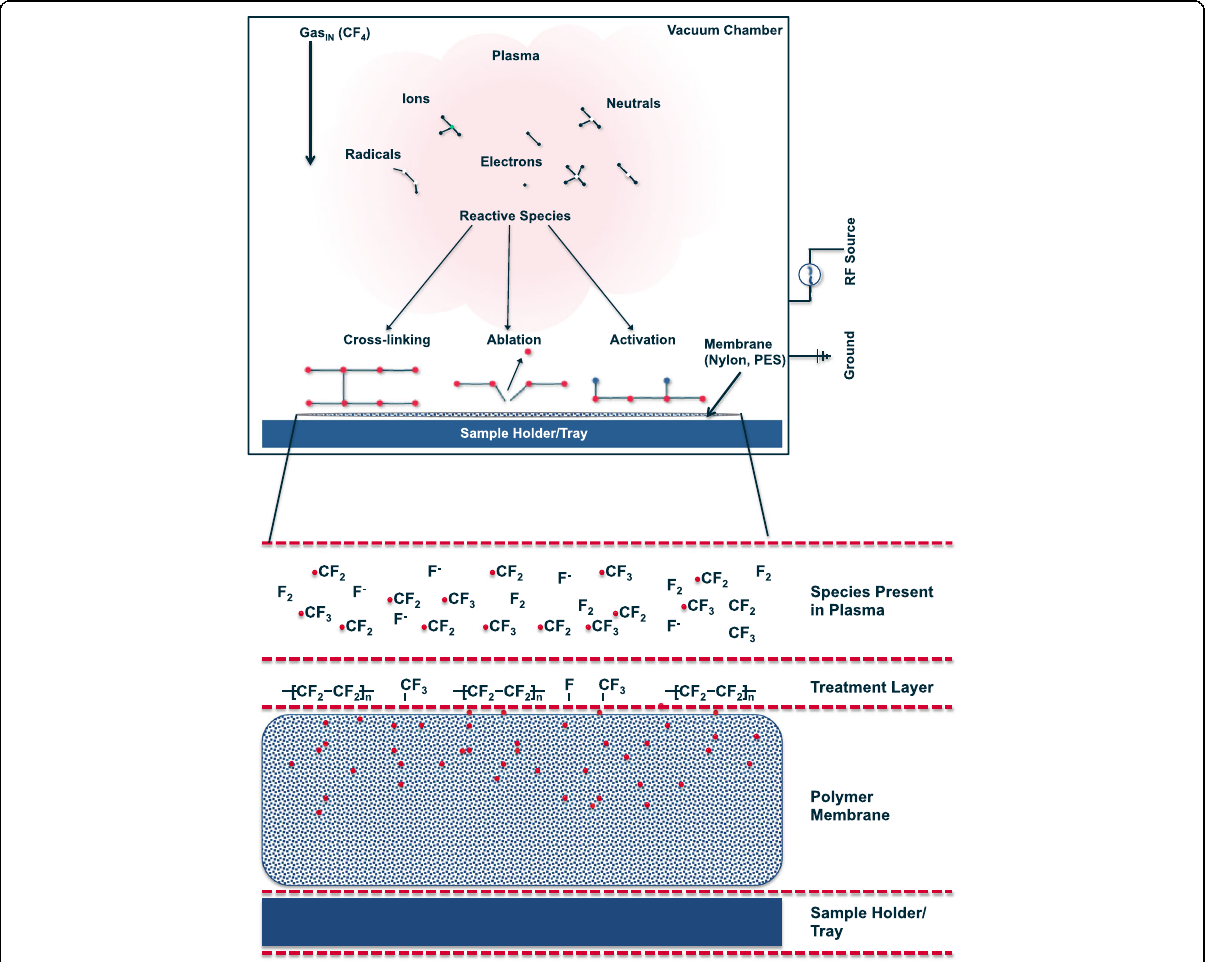
Fig. 7 Schematic illustration of CF4 plasma treatment on nylon and PES membranes adapted from references (Wei et al. 2012; Hopkins and Badyal